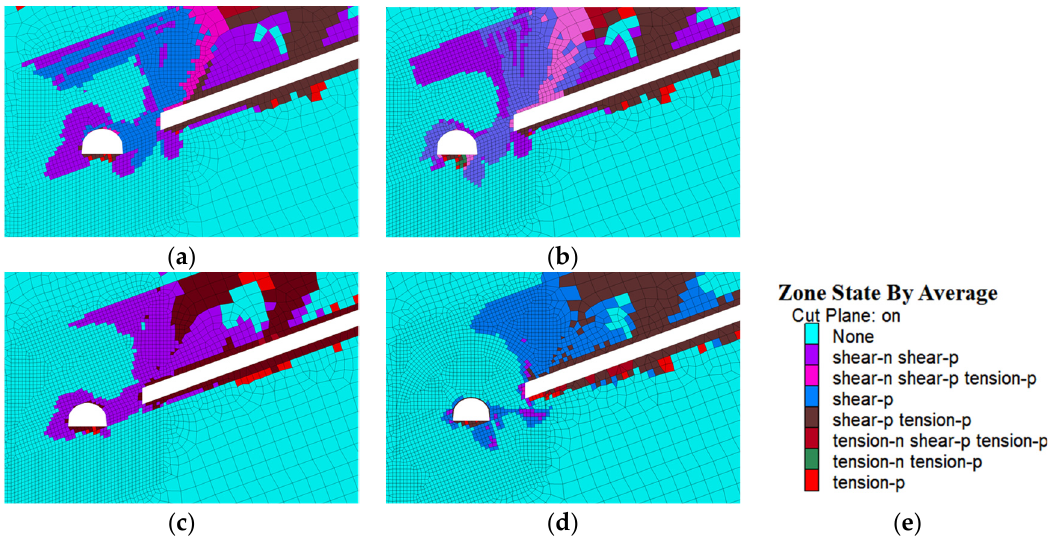
Figure 6. The distribution of plastic zone of surrounding rock under different supporting methods. ( a ) No support, ( b ) U-shaped steel, ( c ) anchor cable, ( d ) CUSG, and ( e ) state description.